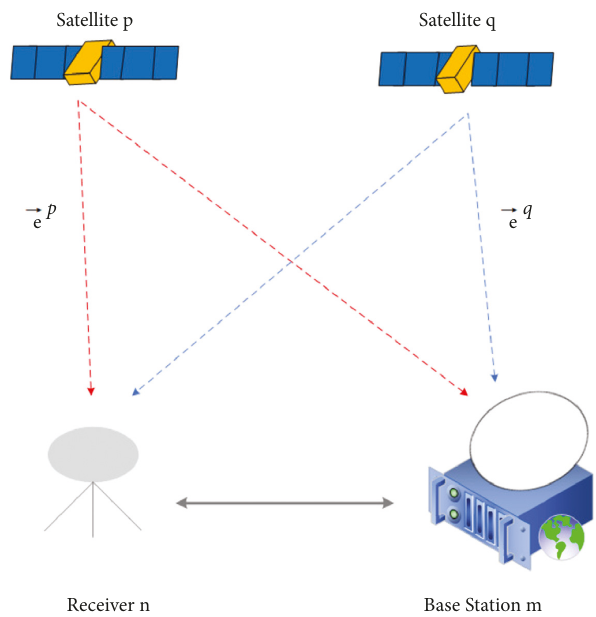
Figure 2: The differential positioning diagram between reference base station m and receiver n